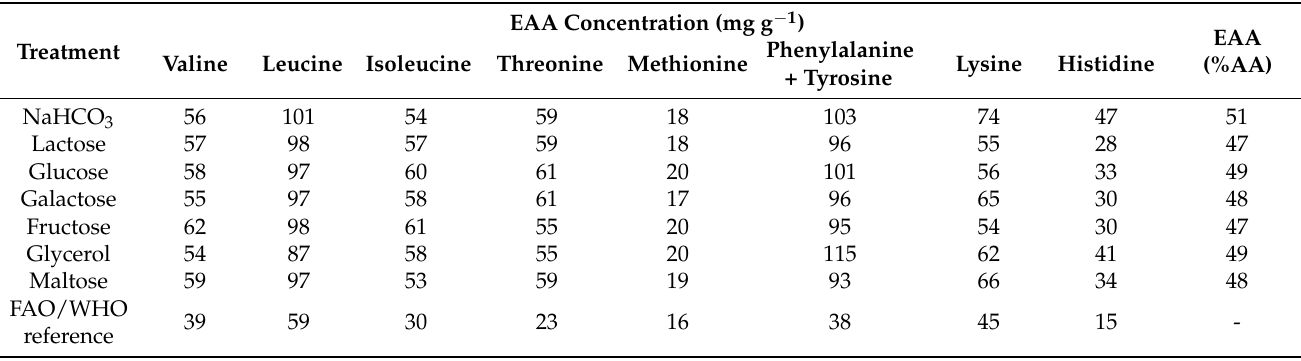
Figure 4. Essential amino acid index for each treatment in the mixotrophic experiment. The horizontal dashed red line represents the FAO/WHO threshold. Table 5. Essential amino acid from the mixotrophic experiment. Concentrations are given in mg total protein g − 1